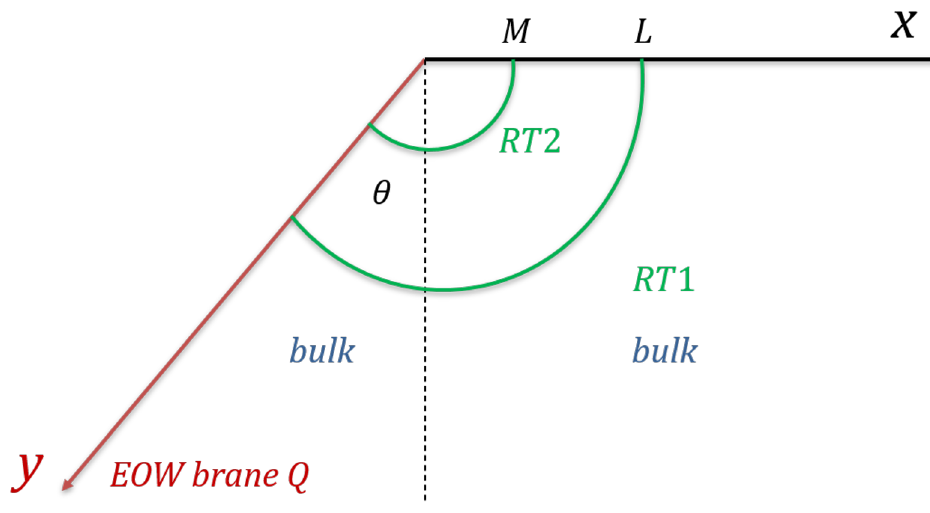
Figure 3 . Defect extremal surface in the disconnected